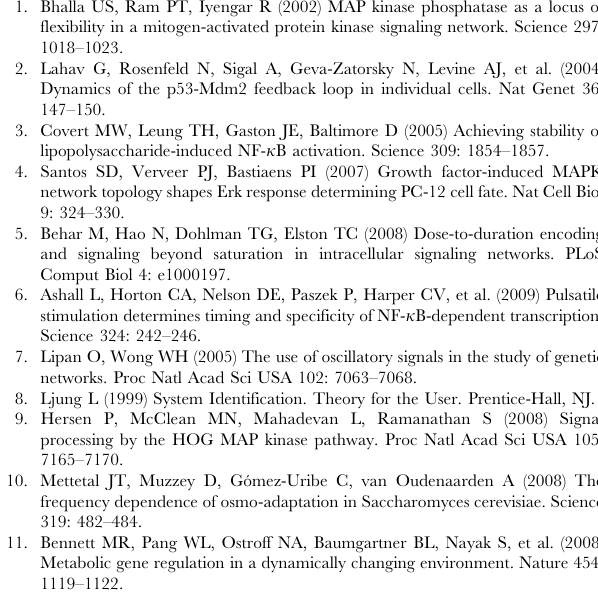
Colored lines: theoretical background spectra. Red: linear cascade. Blue: coherent FFL. Green: incoherent FFL. Crosses mark the peak height at the signal frequency for each genetic circuit. Inset: Numerical peak heights as a function of input frequency (black circles). Red and green lines correspond to the theoretical amplitudes A 2 ( v I ), Eq. (2) in main text, for the linear cascade and incoherent FFL, respectively. C. Output coefficient of variation as a function of output susceptibility [from Eq. (2.44) in Text S1] at s SI = 2 for a linear cascade (red) and a coherent FFL (blue). Time scales are t I = t S = t O = 1, ‘‘system size’’ factor V = 100 for all components (with equilibrium values I eq = S eq =O eq =1) and the rest of the interactions change in the interval [0,5] as in main text. D. Amplitude of maximum oscillatory response versus fluctuation power spectrum at the same frequency, for the same sampling of circuits shown in panel C. Found at: doi:10.1371/journal.pone.0012314.s006 (2.23 MB EPS) Figure S6 Noise frequency filtering range in negative feedback and incoherent FFLs. Filter range, Eq. (4.69) in Text S1, for negative feedback circuits (A) and incoherent FFL circuits (B) as a function of feedback and relative strength, respectively. The shaded region in panel A marks the regime where fluctuations are completely filtered out (FS . 5), since they are shifted at frequencies higher than the oscillatory response bandwidth. Found at: doi:10.1371/journal.pone.0012314.s007 (0.20 MB EPS) Figure S7 FFL interactions are required for optimal amplitude/ frequency detection. A. Relative frequency of two-component detection motifs simultaneoulsy improving amplitude/frequency detection in a noiseless situation (both susceptibility and band- width larger than the linear cascade limit). B. Relative frequencies of two–component detection modules with both amplitude and frequency signal-to-noise rations larger than the linear cascade limits. CFFL: Coherent FFL. IFFL: Incoherent FFL. PF: Positive feedback. NF: Negative feedback. PAR: Positive autoregulation. NAR: Negative autoregulation. F: Feedback (it can be either positive or negative). MIX: Combination of at least two interactions (feedback or autoregulations) with different sign. See Section 5 in Text S1 for statistical estimations.